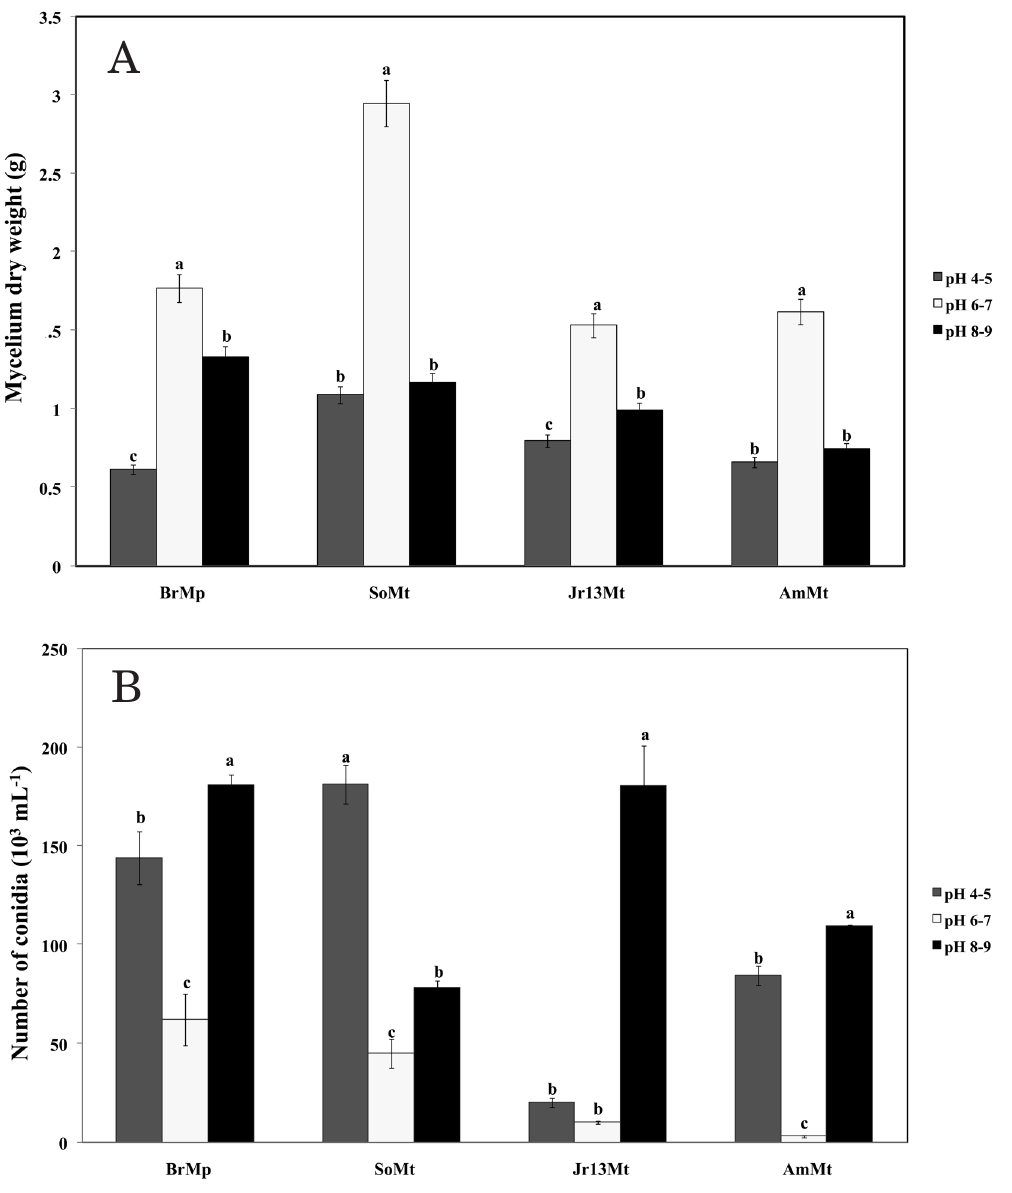
Figure 3. Mycelium dry weight (A) and conidia production (B) of four Cercospora medicaginis strains after 4 weeks of culture on a wheat bran-juice based medium with different pH